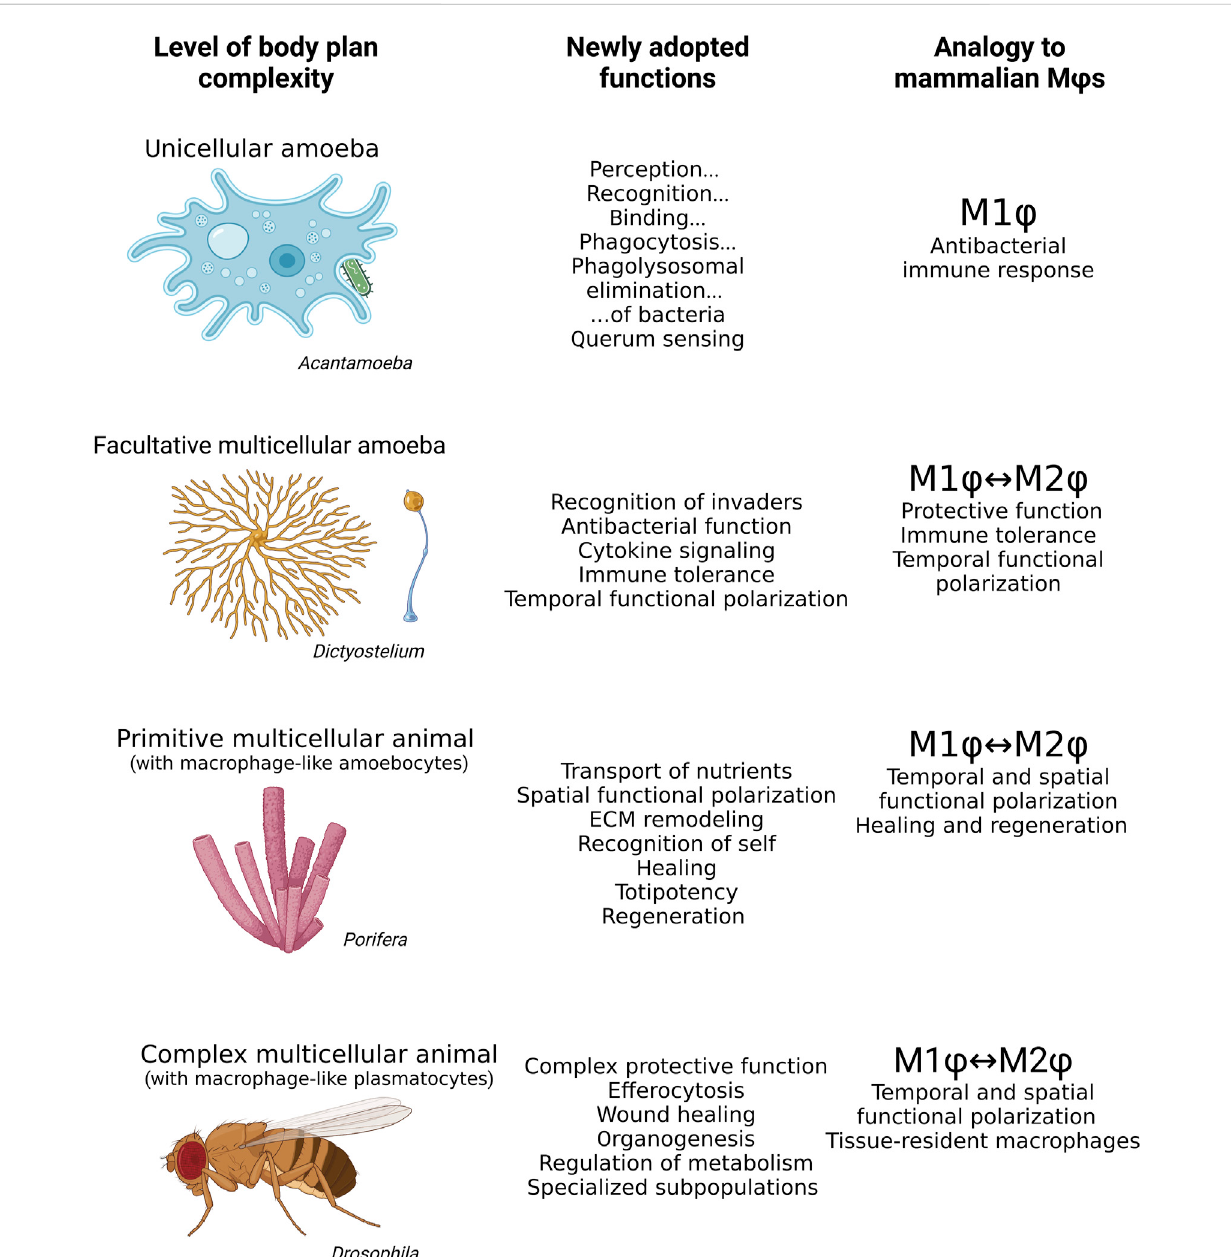
FIGURE 3 Mammalian macrophages share many features with Acanthamoeba, Dictyostelium , archaeocytes in Porifera, and plasmatocytes in Drosophila . While the bacteria hunting unicellular Acanthamoeba resembles the M1 polarization phenotype of mammalian macrophages, Dictyostelium exhibits M1 or M2 features of mammalian macrophages depending on its life stage. The archaeocytes of aquatic sponges have both M1 and M2 macrophages within a single organism, phenotypically responding to situation context rather than life stage. Plasmatocytes of Drosophila exhibit a wide range of highly specialized roles in the organism in addition to M1 and M2 polarization. M ϕ s,